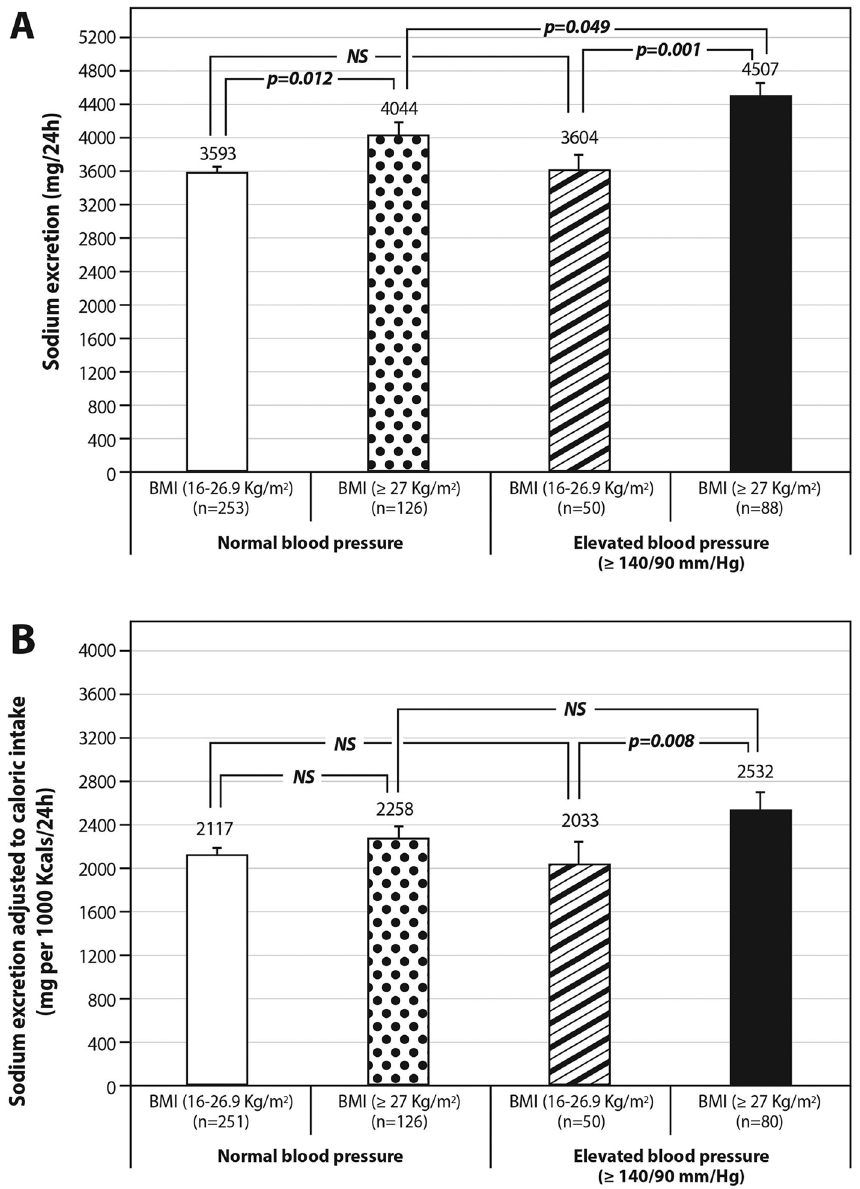
Figure 6. ( A , B ) Sodium excretion stratified by measured hypertension and overweight/ obesity status. 24-h sodium excretion ( A ) and 24-h sodium excretion density (excretion per 1000 Kcals) ( B ) among 4 combined phenotypes of hypertension and BMI: (1) normotensive + non-obese; (2) normotensive + overweight/obese; (3) hypertensive + non-obese; (4) hypertensive + overweight/obese. The different excretion levels of sodium were compared across each two pairs of phenotypes using independent t-test. Error bars represented the standard